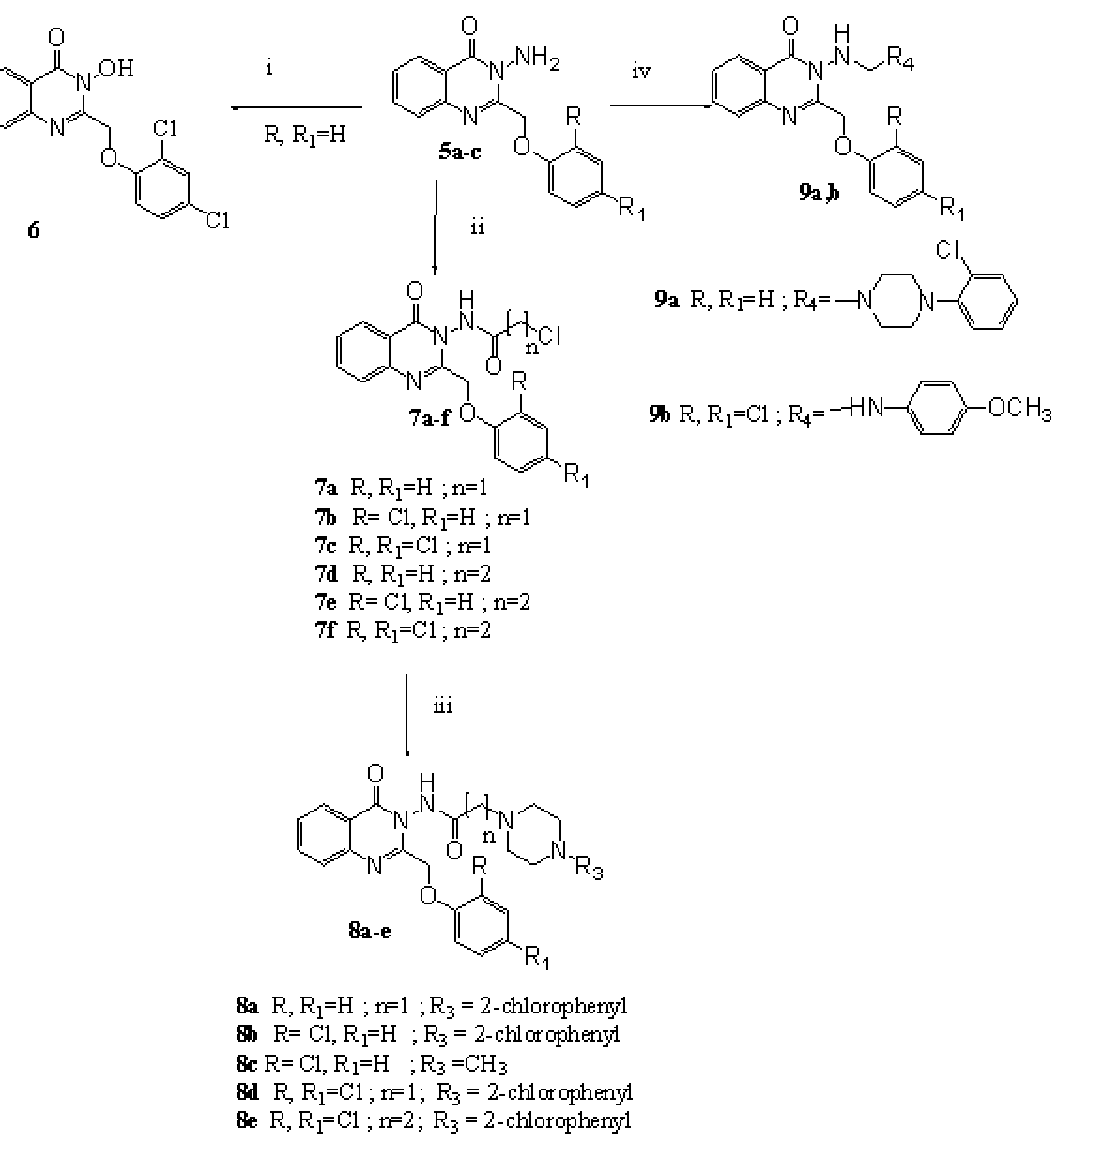
Scheme 2 . Synthetic Pathway for Compounds 6-9